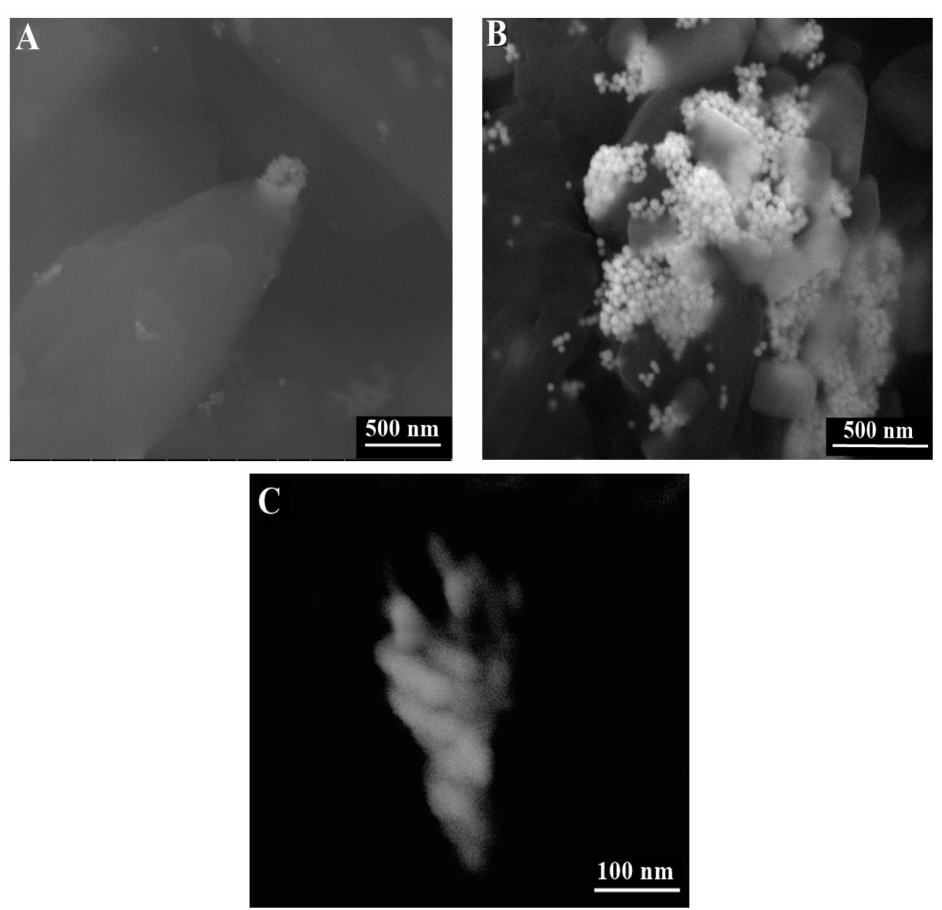
Figure 8. ESEM images of precipitates of evaporated; ( A ) GNPs-stabilized suspension in citrate buffer; ( B , C ) DNA/GNPs